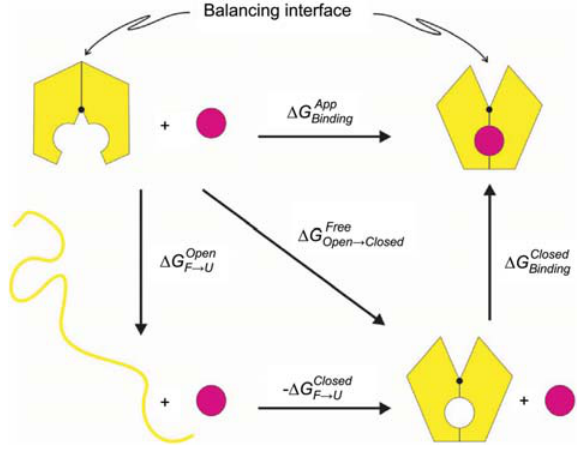
Figure 2 Thermodynamic linkage relationships involving MBP. The ligand is represented by a magenta circle. The protein is colored yellow and appears either in an unfolded state (line) or in a folded one (other). Folded protein displays either an open conformation (top left corner) or a closed one (right corners); the hinge is denoted by a black circle. The balancing interface and the nomenclature for the free-energy changes between thermodynamic states are